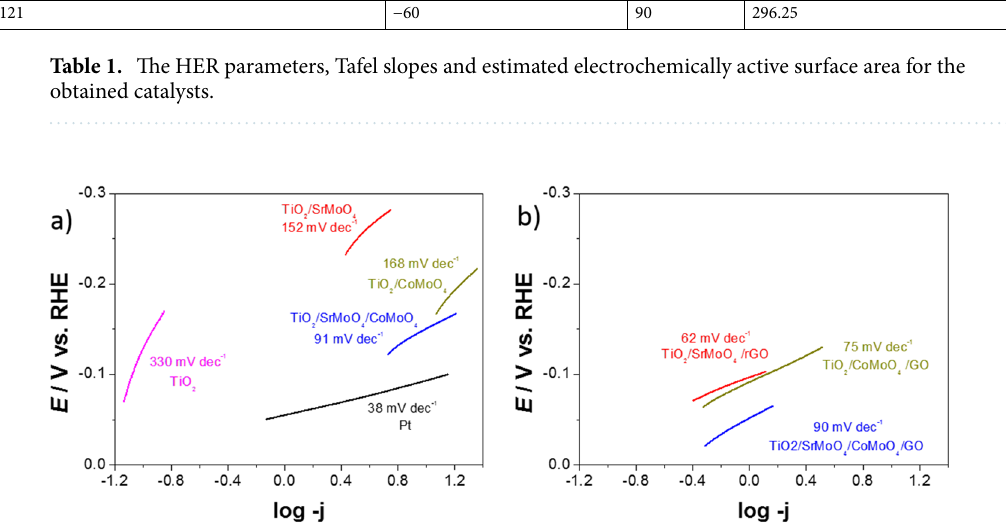
Figure 7. The Tafel plots calculated from the corresponding LSV plots for obtained catalysts ( a ) without and ( b ) with the addition of